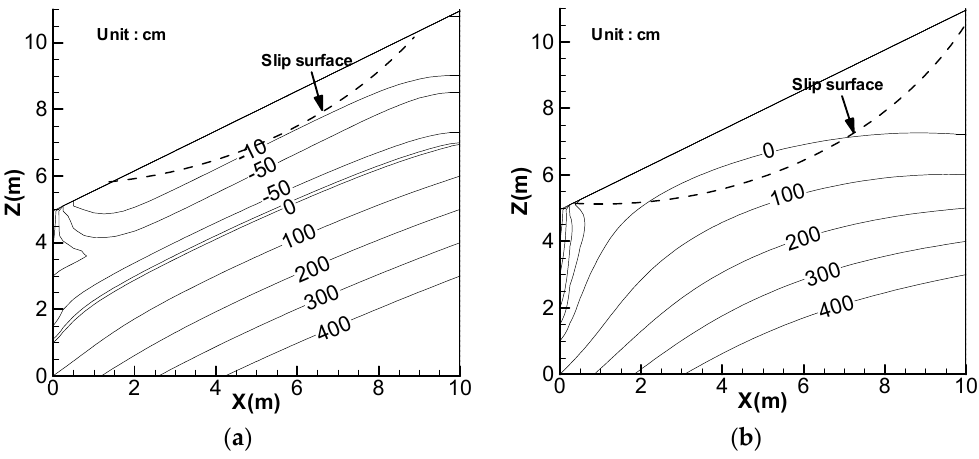
Figure 15. Pressure head contours and slip surface with uniform rainfall of 400 mm for duration of: ( a ) 12 h; and ( b ) 36 h.